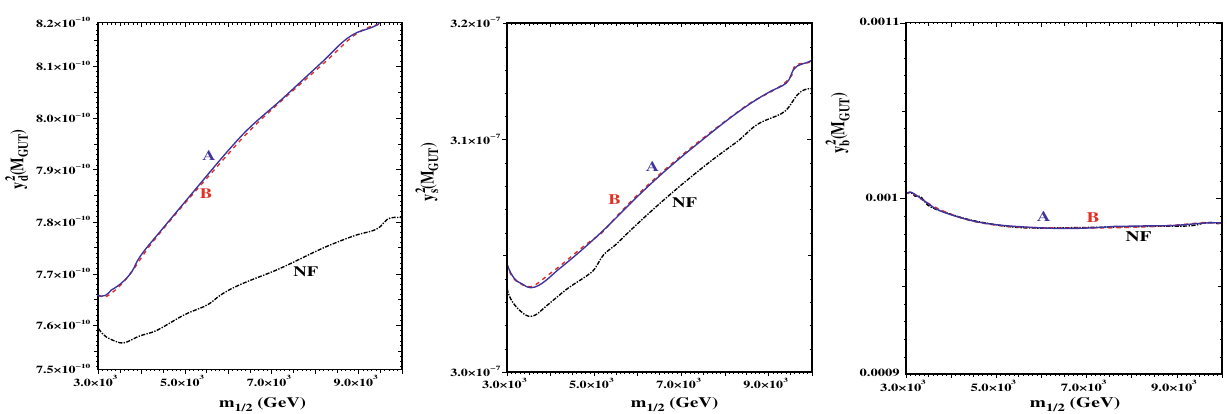
Fig. 2 Comparisons of the values of the Yukawa couplings at M GUT for choices A (blue solid line), B (red dashed line) and NF (black dot-dashed